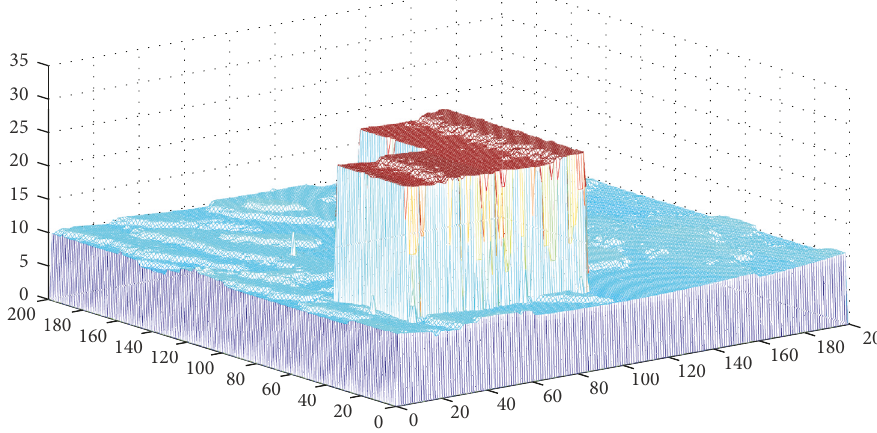
Figure 16: Imaging results.